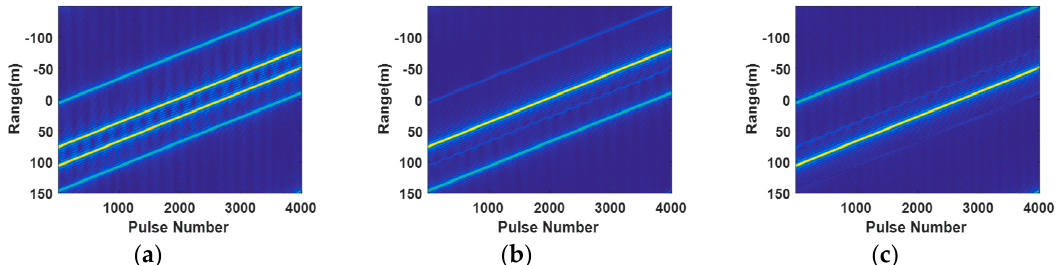
Figure 7. Signal after range compression: ( a ) Original signal after range compression. ( b ) Signal from the first range region after range ambiguity resolution and range compression. ( c ) Signal from the second range region after range ambiguity resolution and range compression.